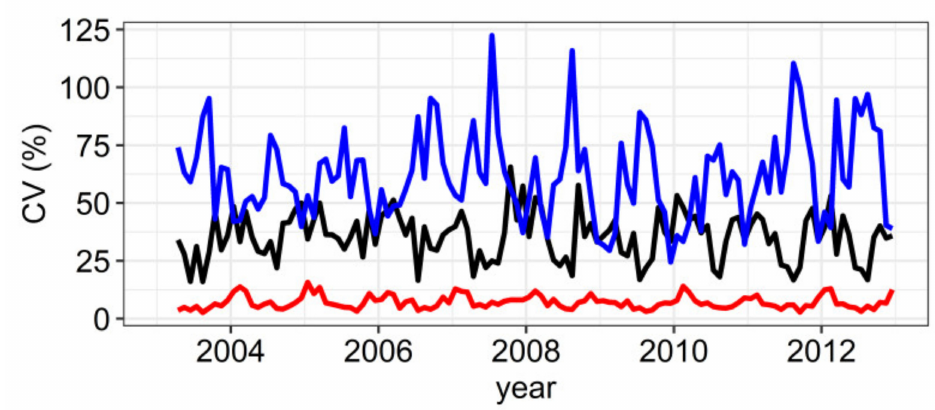
Figure 4. Monthly coefficient of variation (CV, %) of daily values of H er (black), TOC (red), and cloud cover (blue) in Novi Sad, Serbia, for the period April 2003–December 2012.